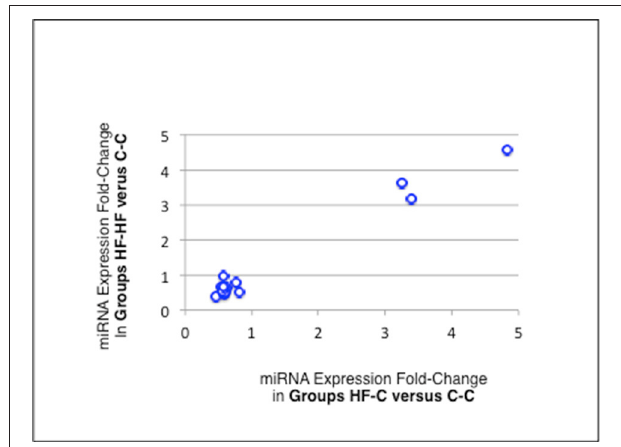
FIGURE 8 | miRNA differential expression in groups HF-C or HF-HF vs. C-C. miRNAs and Partner-miRNAs specified by the genes miR-323, − 3585, − 433, − 485, and − 770 as well as the miRNA miR-547-3p appeared significantly impacted by the sole perinatal unbalanced environment (padj-value < 5.2E-02; see Table 3 ). For each of these miRNAs, the Fold-Change of Expression (FCE) in Groups HF-HF vs. C-C was plotted against the FCE in Groups HF-C vs. C-C. Both FCEs displayed high correlation ( R 2 = 0.98) indicating that the 11 miRNAs defined a subset of miRNAs repeatedly impacted by the perinatal unbalanced environment.